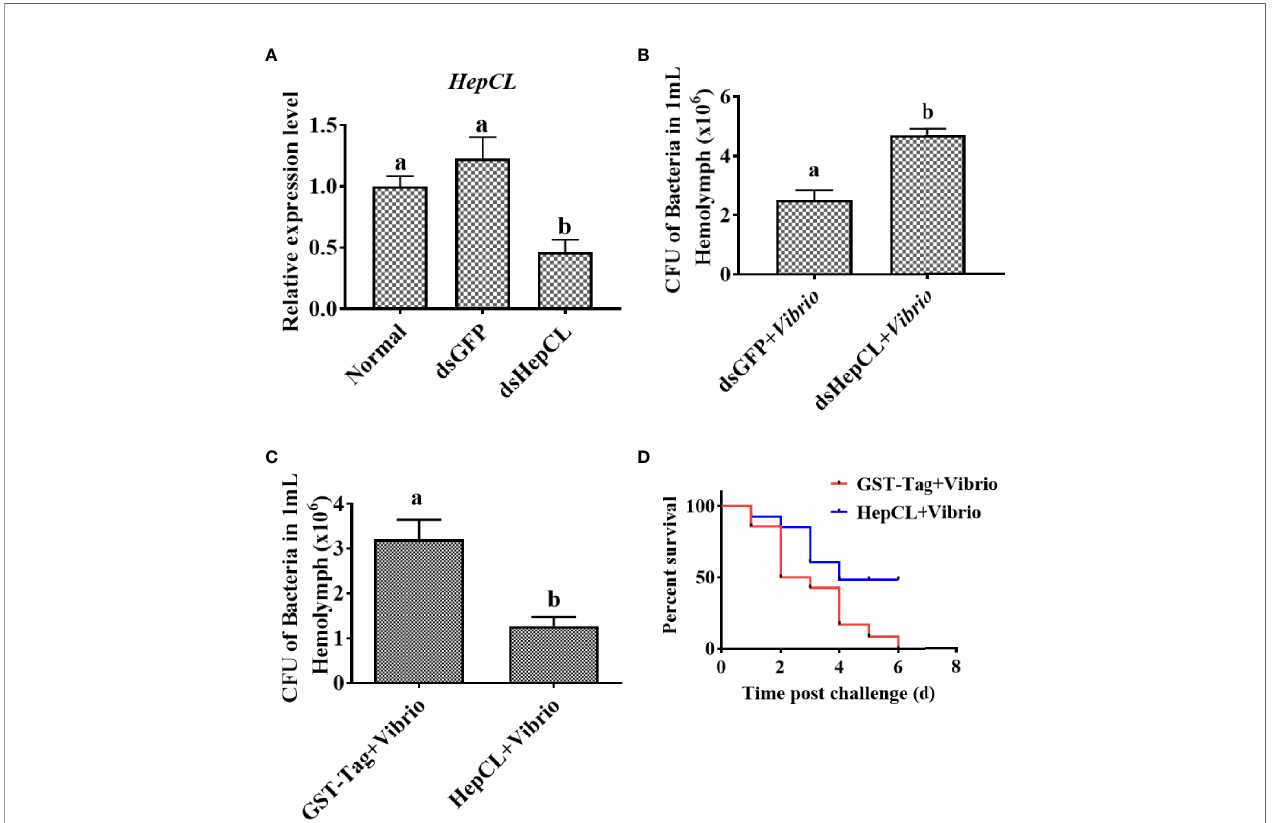
FIGURE 2 | HepCL in fl uence survival rate and bacterial clearance capacity of cray fi sh. (A) After HepCL was knocked down, bacterial clearance experiments were performed. qPCR was used to analyze the interference effect of HepCL. (B) After hep was knocked down, the residual bacteria in cray fi sh were counted, dsGFP was used as control. (C) The bacterial clearance capacity of the cray fi sh was analyzed after HepCL was injected into Cray fi sh, GST- Tag protein was used as control. (D) The survival rate was counted after HepCL and Vibrio injected, GST-Tag was used as the control. Differences among the groups were analyzed using a t-test, different letters indicate signi fi cant differences p < 0.05.